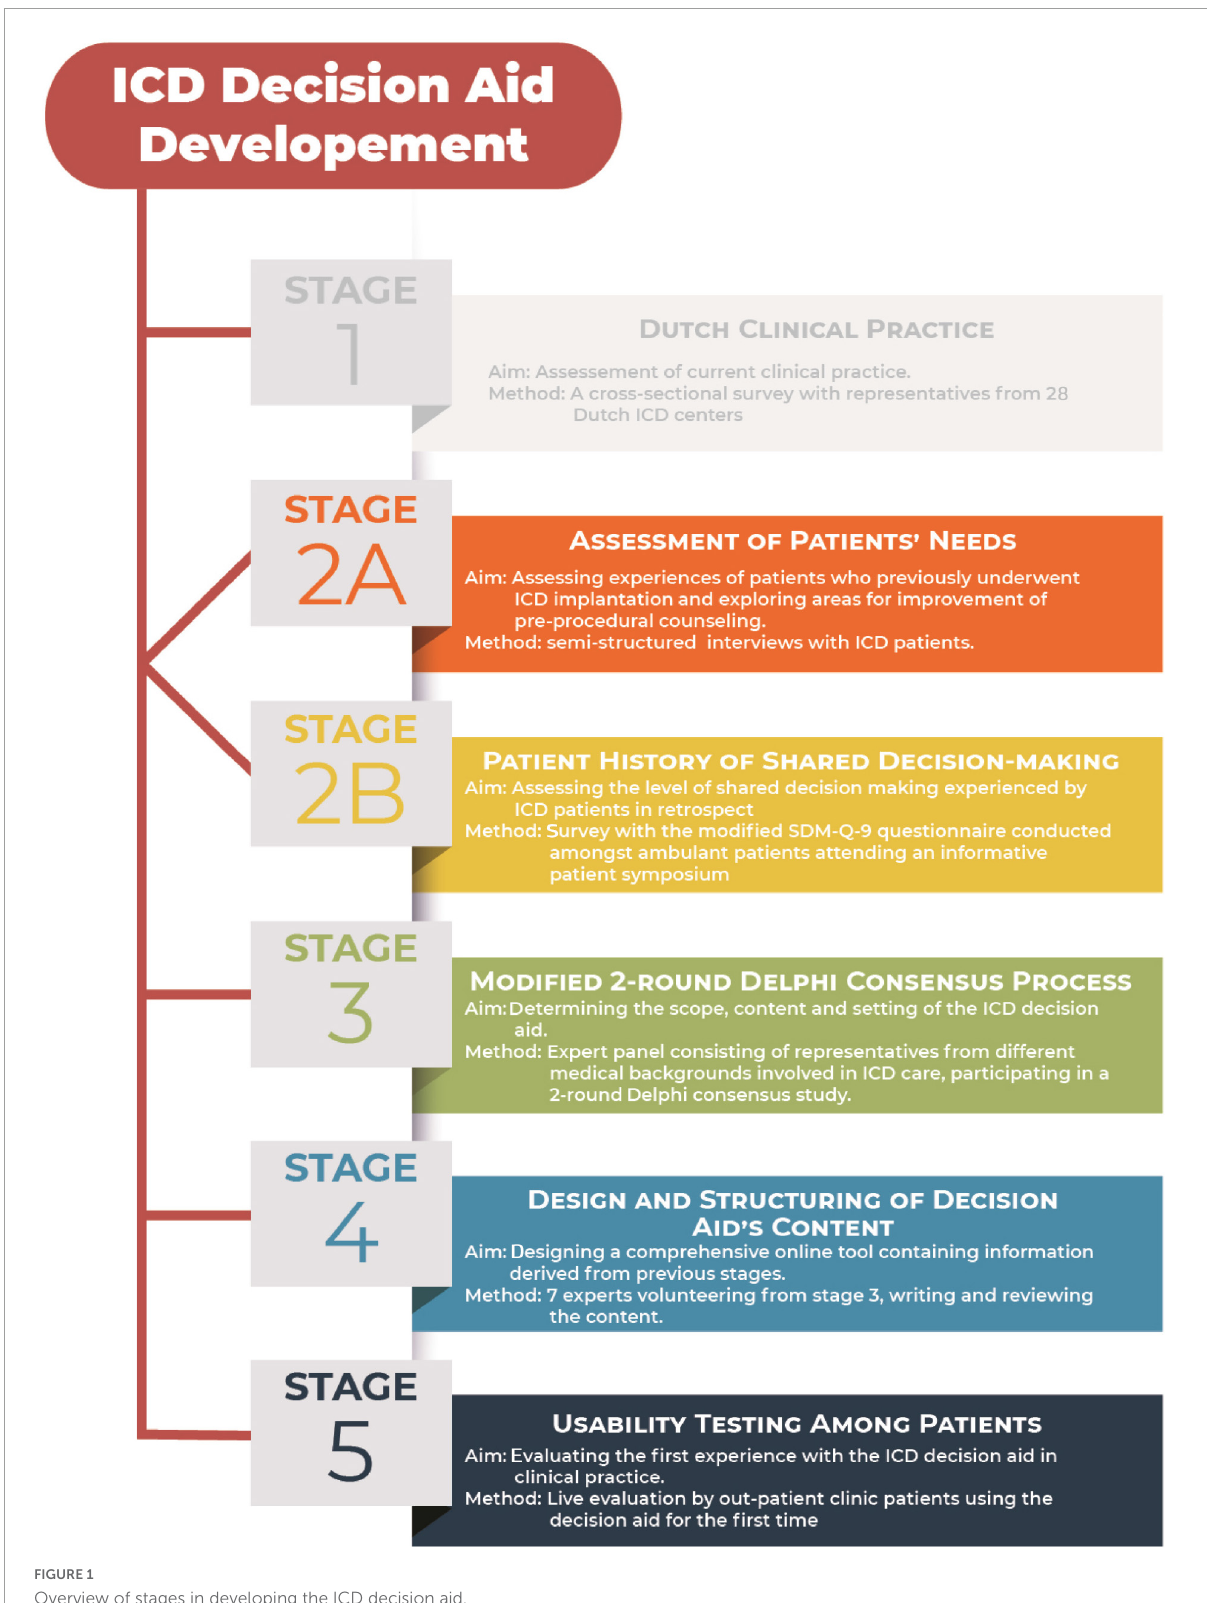
FIGURE1 Overview of stages in developing the ICD decision